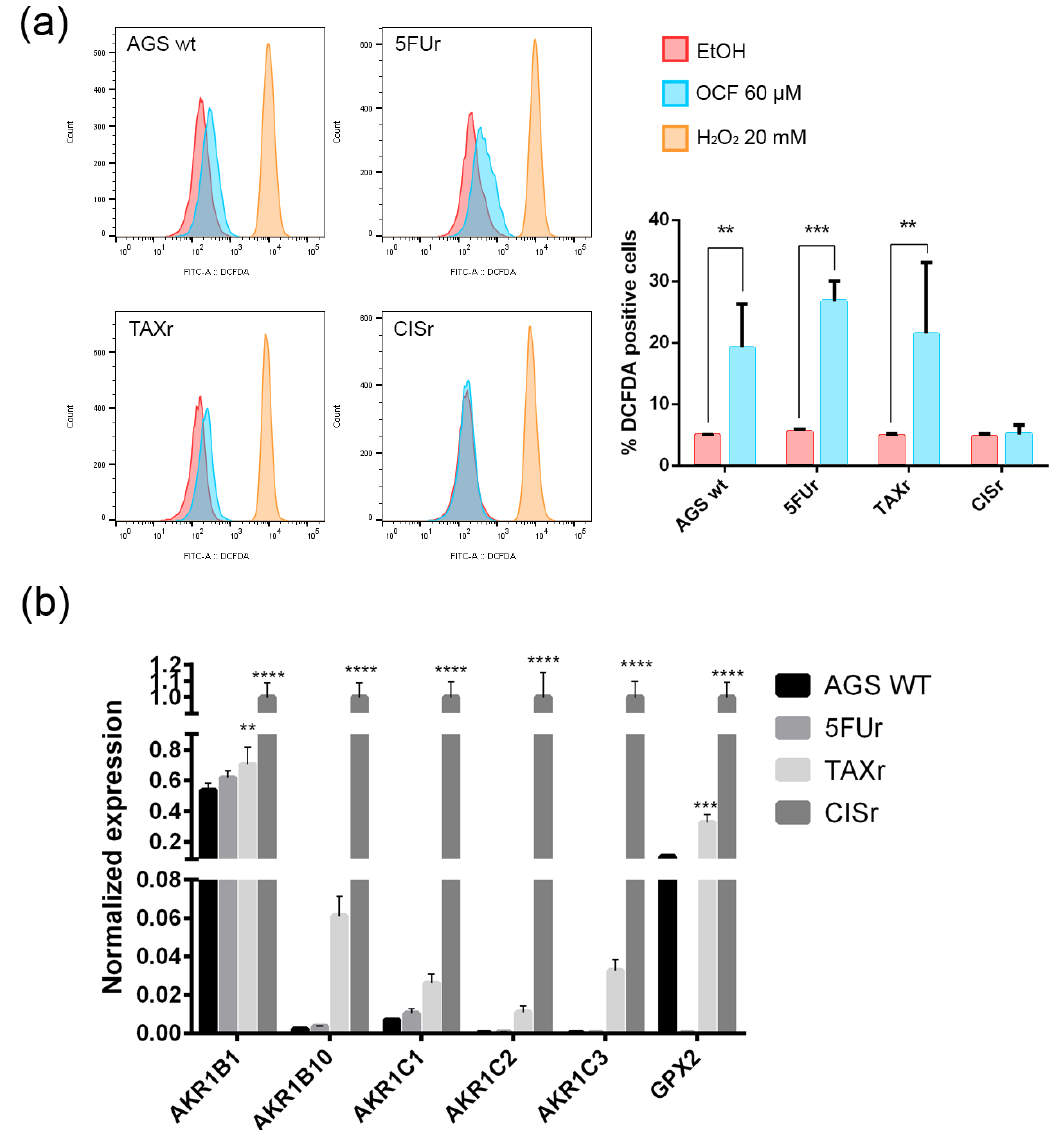
Figure 10. ROS production by the OCF treatment and the antioxidant enzymes levels. Flow cytometry graphs and the corresponding ROS quantification in the cells treated for 72 h with vehicle or with a 60 µ M dose of the OCF ( a ). Real-Time PCR analyses for the antioxidant enzymes in the AGS wt, 5FUr, TAXr and CISr cells ( b ). Data are presented as mean ± SD of three independent experiments. Results of the representative experiments are shown. ** p < 0.01, *** p < 0.001; **** p < 0.0001; ( a ) two-way ANOVA Sidak’s multiple comparisons test; ( b ) Two-way ANOVA Dunnett’s multiple comparisons